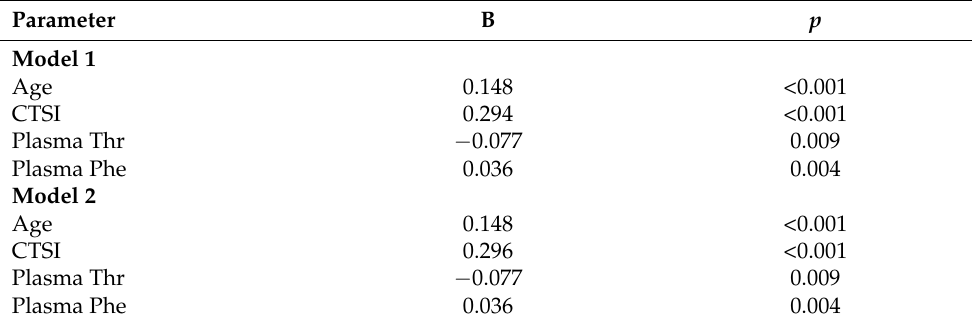
Table 2. Predictors of mortality.